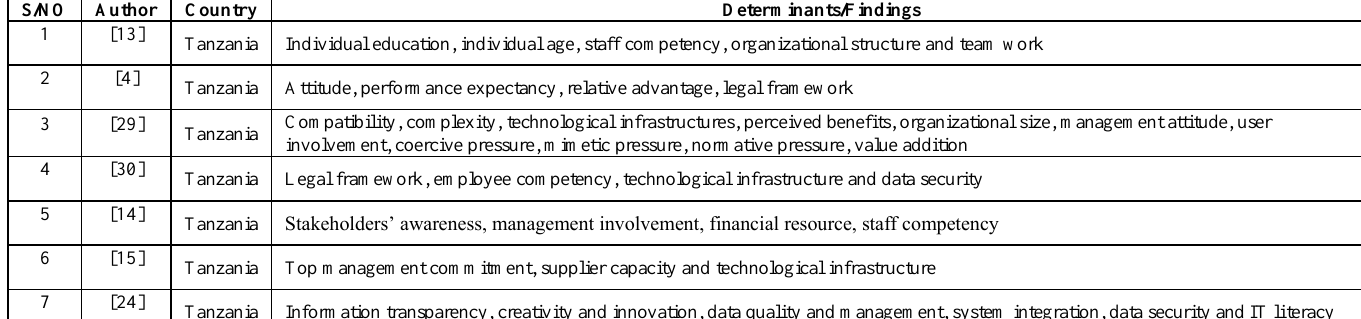
Table 1: Determinants of e-procurement adoption in Tanzania and Kenya